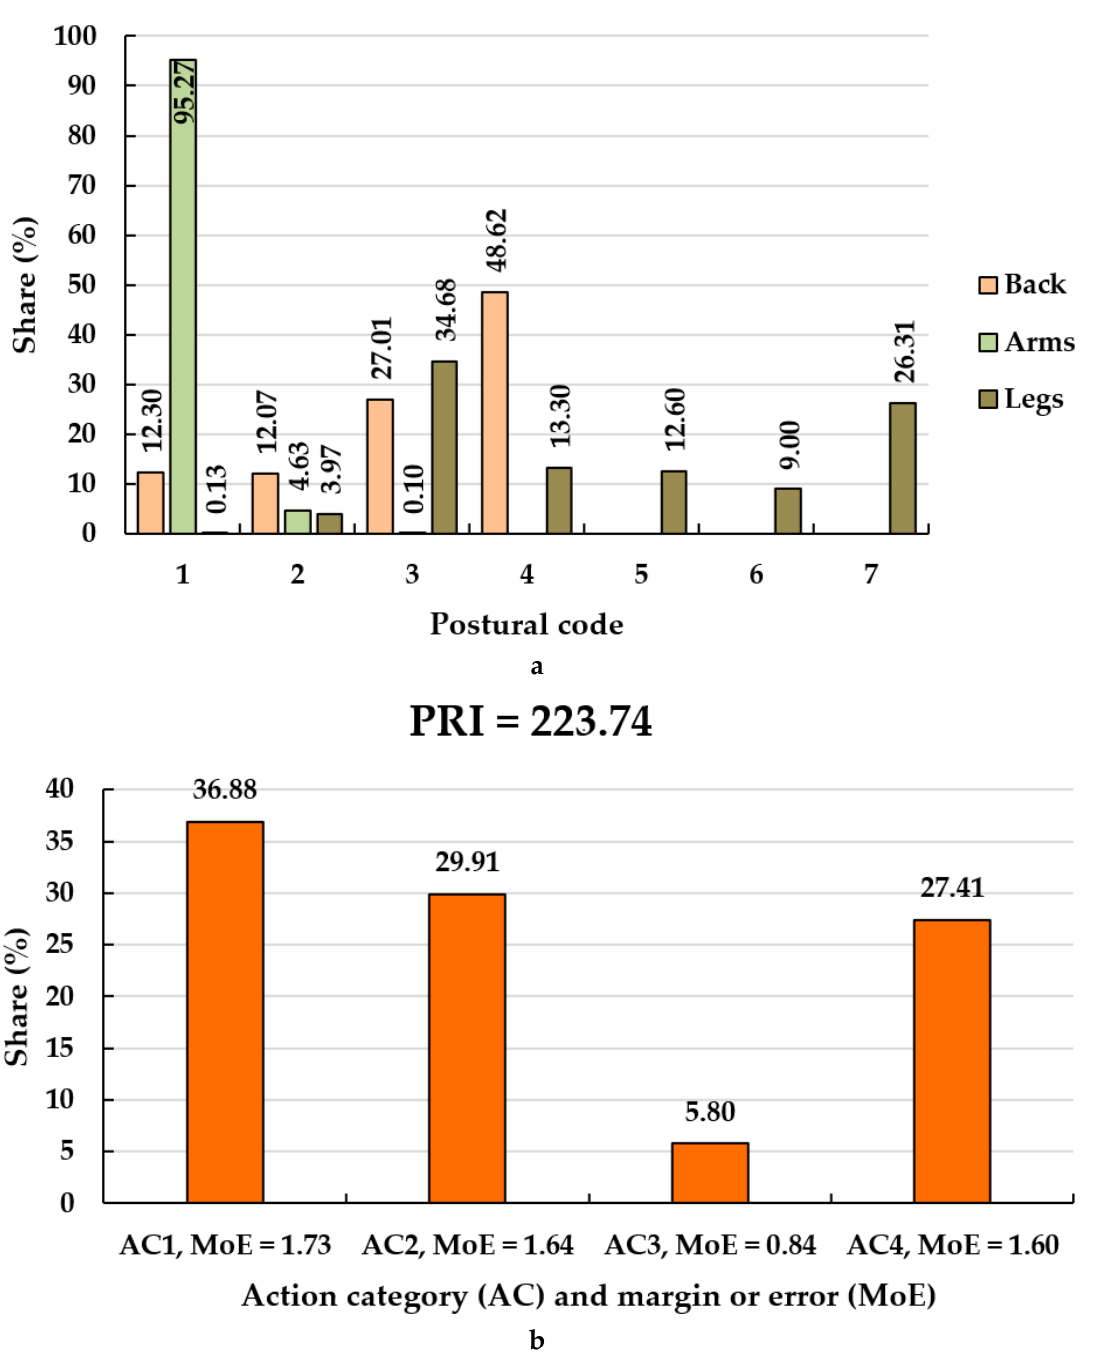
Figure 6. Results of postural analysis. Legend: ( a )—relative frequencies of the back, arms and legs on postural codes; ( b )—relative frequencies of body postures on action categories, the estimated postural index and margin of errors per action categories.